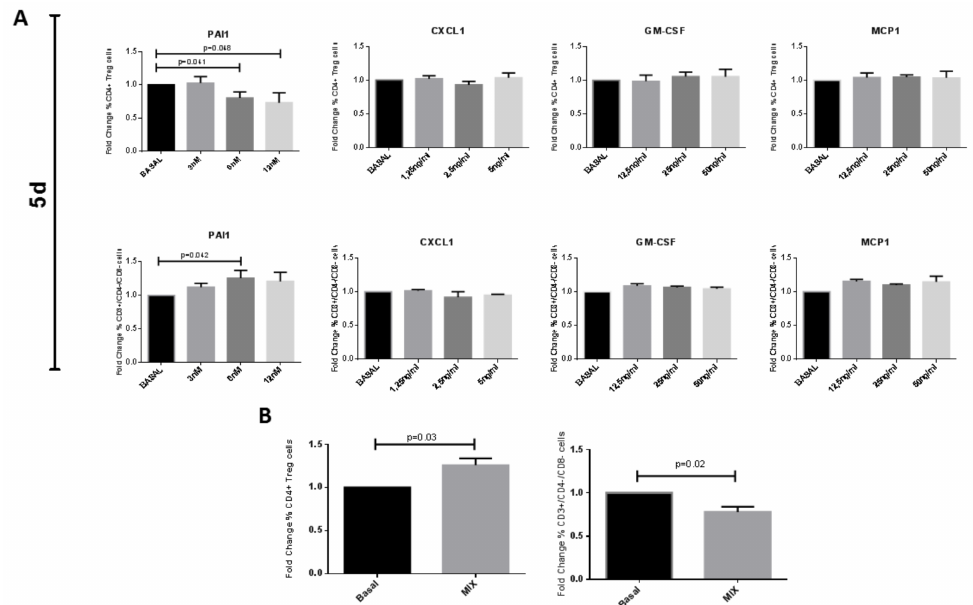
Figure 6. A cocktail of cytokines mediated the immunomodulatory effect of ARPCs after 5 days. ( A ) Con-A activated PBMC were exposed to different crescent concentrations of PAI1, CXCL1, GM-CSF, and MCP1 for 5 days. Percentages of Tregs and DN T cells were analyzed using flow cytometry. PAI1 was able to significantly decrease the % of Tregs at 6 nM and 12 nM but significantly increased DN T cells at 6 nM. None of CXCL1, GM-CSF, and MCP1 were able to significantly modulate T cell subsets alone. ( B ) When Con-A activated PBMC were exposed to the 4 cytokines in mix for 5 days, an immunomodulatory effect was observed on Tregs and DN subsets, similar to the ARPCs co-culture effect. Data represent the fold change of PBMC percentage respect to PBMC Con-A (Basal). Data are representative of six independent experiments (means ±